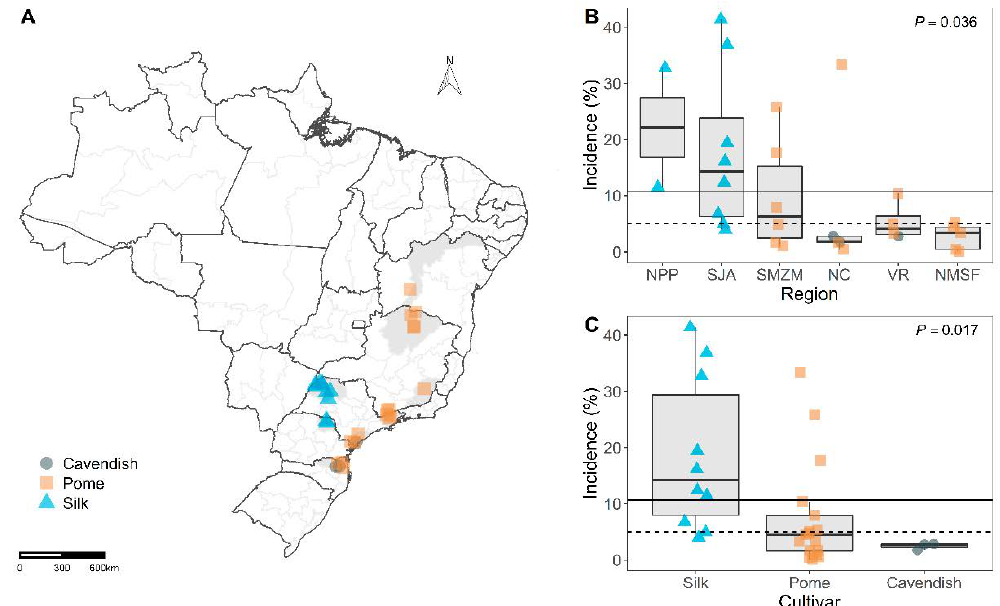
Figure 1. ( A ) Location of the 30 sampled fields distributed in five states of Brazil. Mesoregions are shaded in gray, and the exact location of the fields was identified by geometrical shapes that correspond to banana cultivars. Fields located close to each other appear superimposed on the map and geometric shapes are darker. ( B ) Boxplots illustrate the incidence of Fusarium wilt on banana fields in different regions of Brazil and ( C ) for different cultivars. The average and median values are represented by dashed and solid lines, respectively.